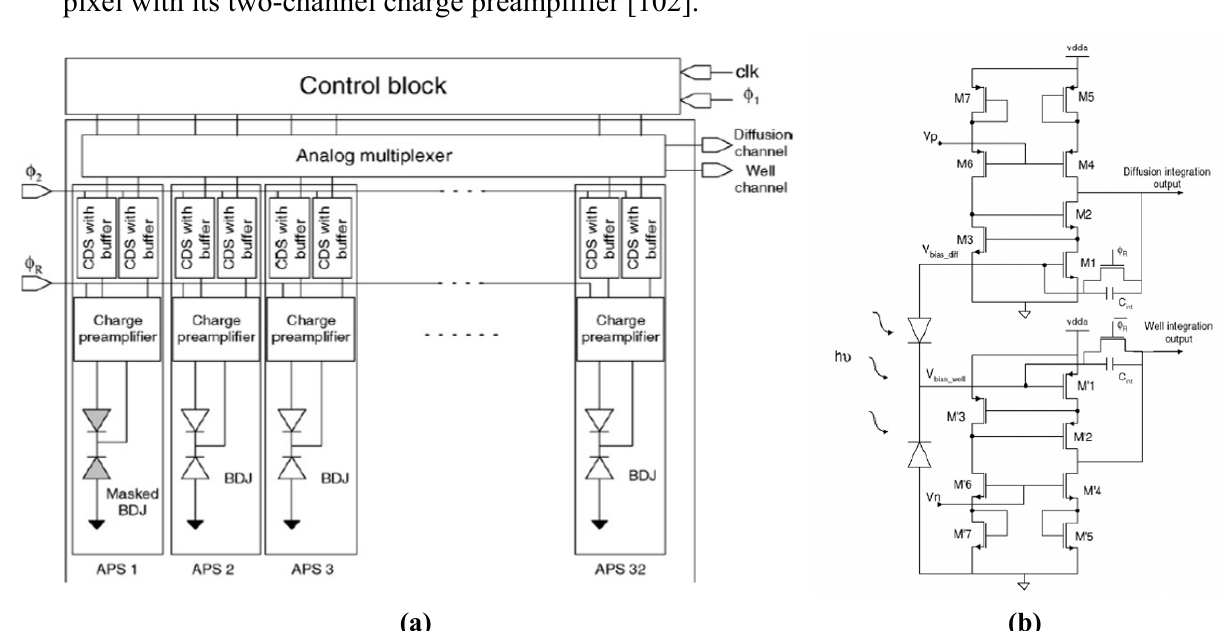
Figure 19. (a) Block diagram of the CMOS APS linear array and (b) schematic of one pixel with its two-channel charge preamplifier